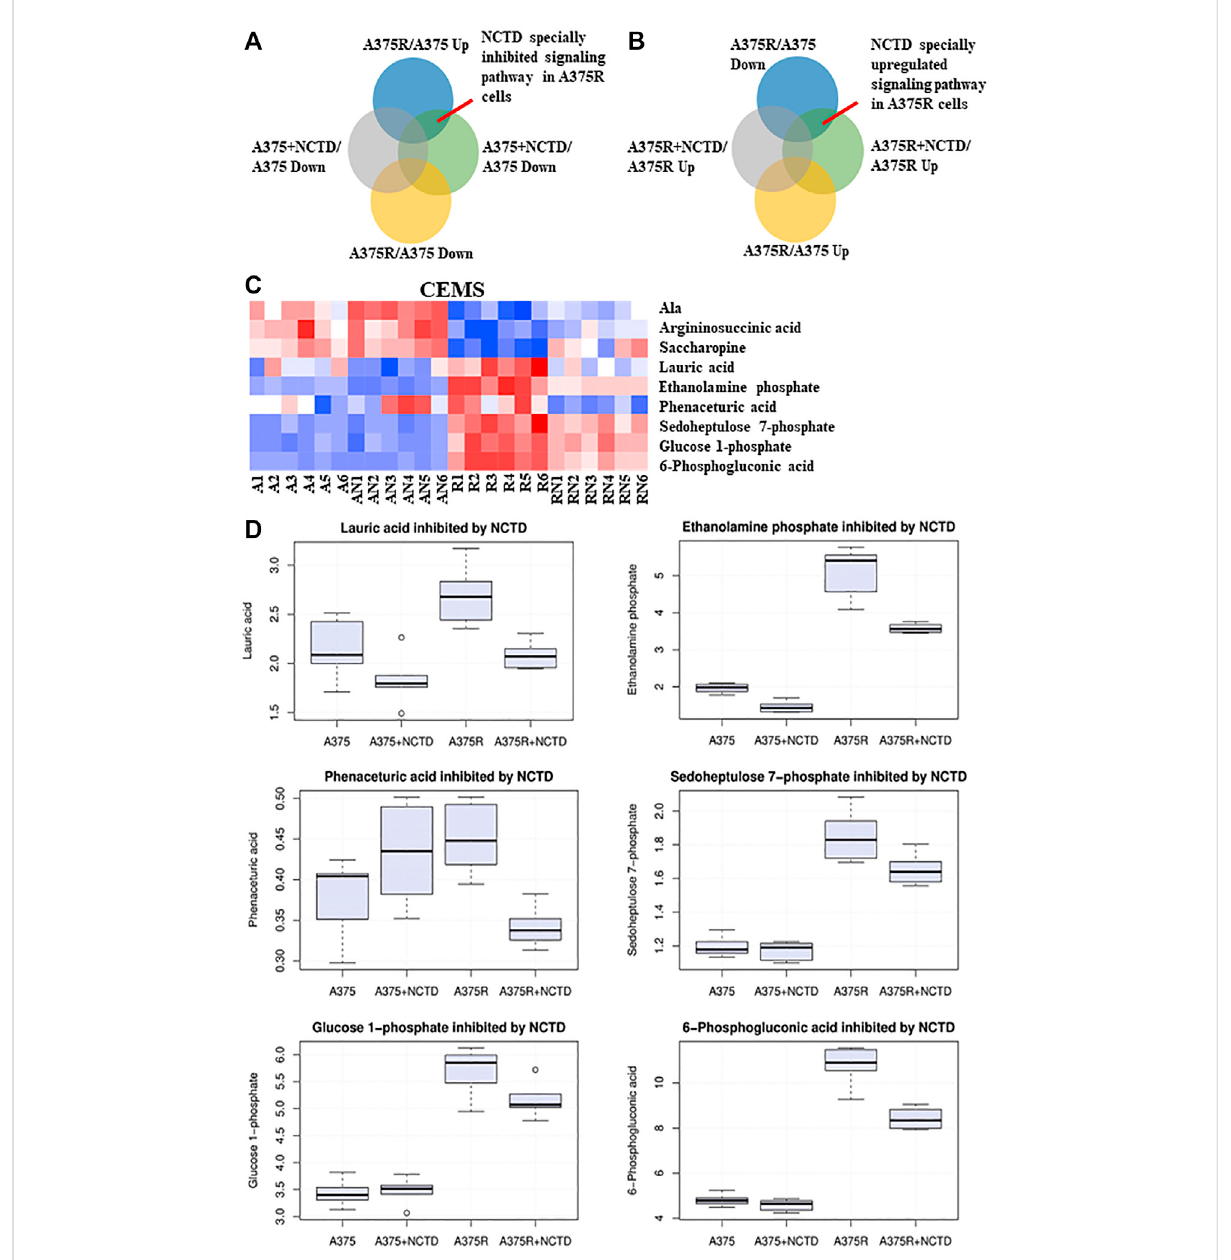
FIGURE 3 NCTD inhibited Vem-induced upregulation of PPP based on CE-MS metabolomics analysis. (A,B) Intersection of many sets of metabolites revealed, especially downregulating and upregulating metabolites of NCTD in A375R cells. (C) Heatmap of signi fi cantly changed metabolites based on CE-MS in the A375, A375R, A375 + NCTD, and A375R + NCTD samples. Red in the heatmap represented the upregulated metabolites, and blue represented downregulated metabolites. (D) Six histograms showed statistically signi fi cantly downregulated metabolites in A375R